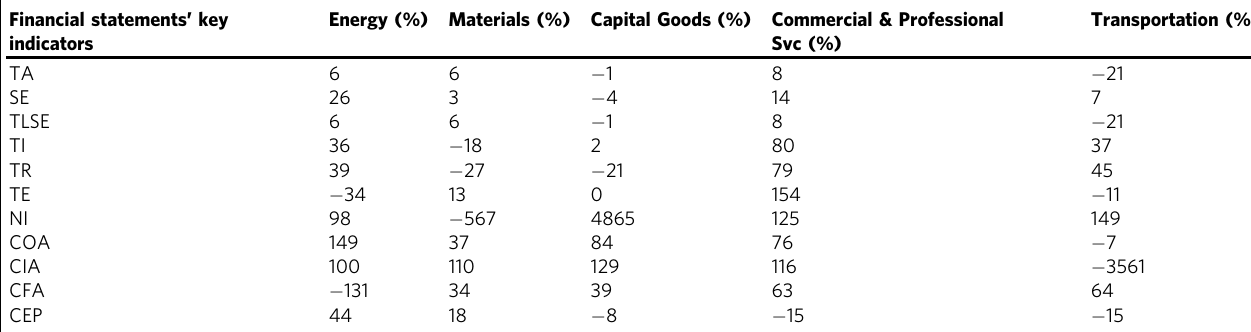
Table 5 increase or decrease in values of fi nancial statements ’ key indicators in terms of the average between Commercial Materials, Energy, Capital-Goods, & Professional Svc and Transportation